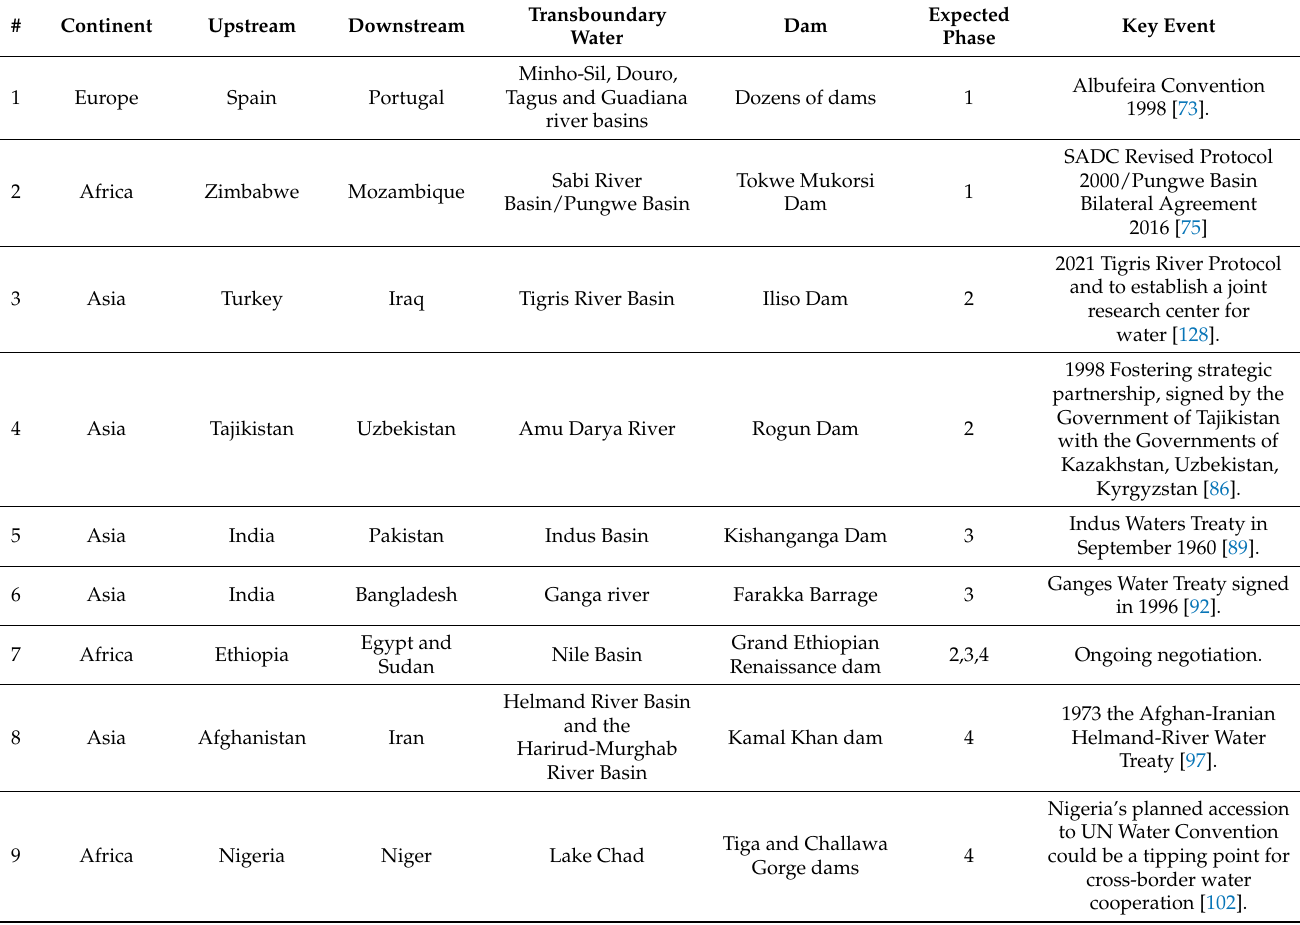
Table 1. The 21 research case studies and expected